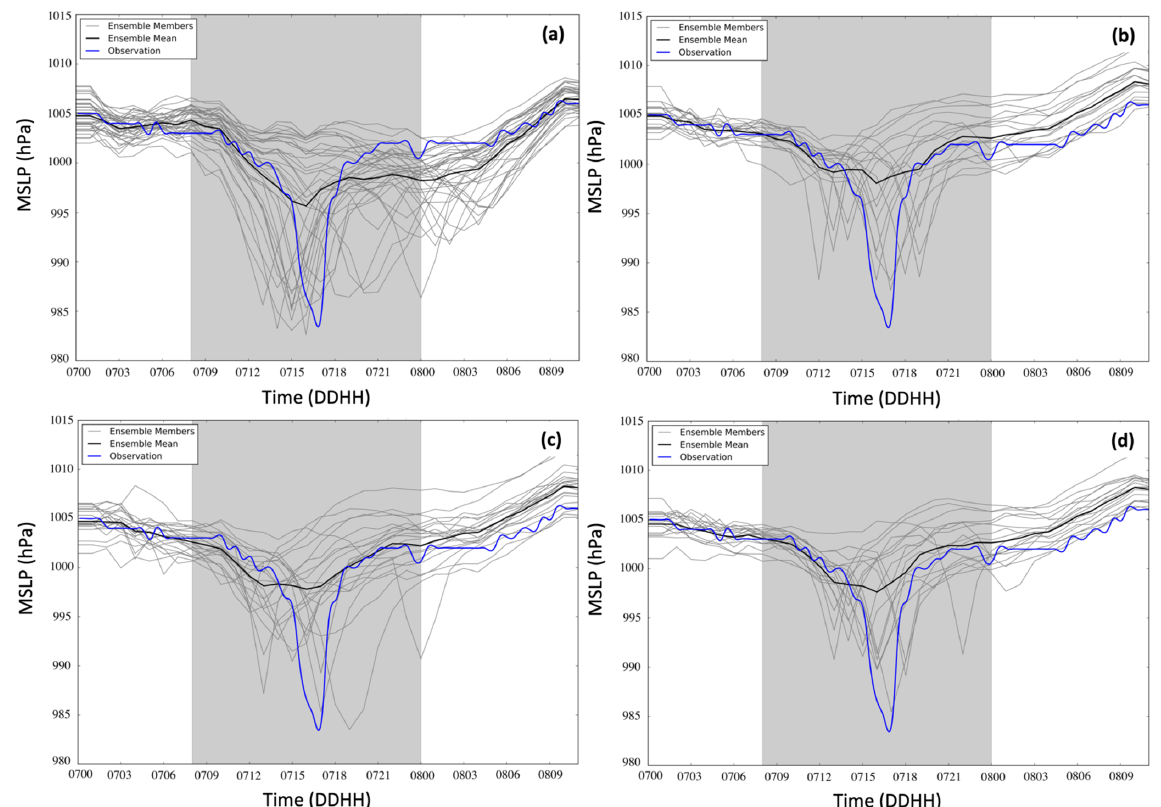
Figure 13. Ensemble (solid grey lines) and ensemble mean (solid black lines) surface pressure evolution at the closest grid point to Malta for (a) NODA, (b) SYN, (c) RSAMV and (d) CNTRL experiments. Surface pressure registered by METARs in Malta’s airport is also depicted (solid blue lines). Grey shaded area represents the most intense period of the medicane, which we are most interested